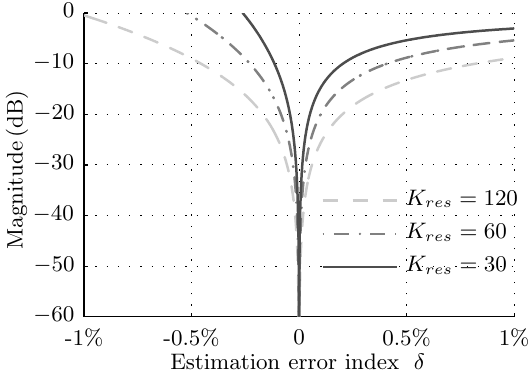
Figure 6. Magnitude of α ( s ) | ˆ f g = 50Hz.